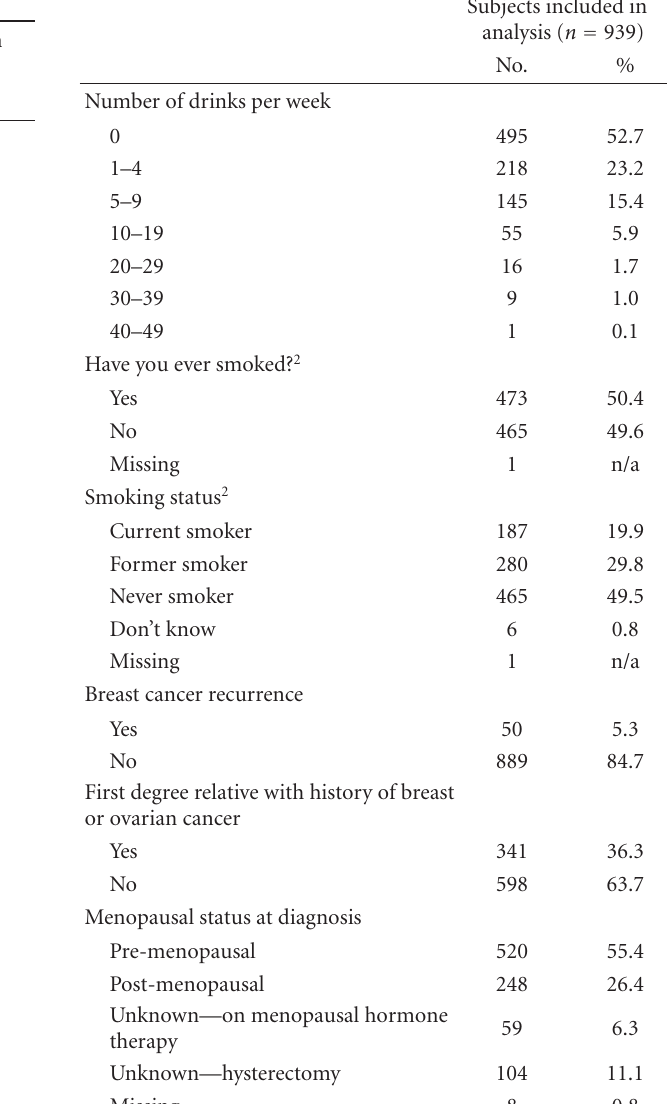
Table 1: Characteristics of the study population of women with breast cancer from questionnaire